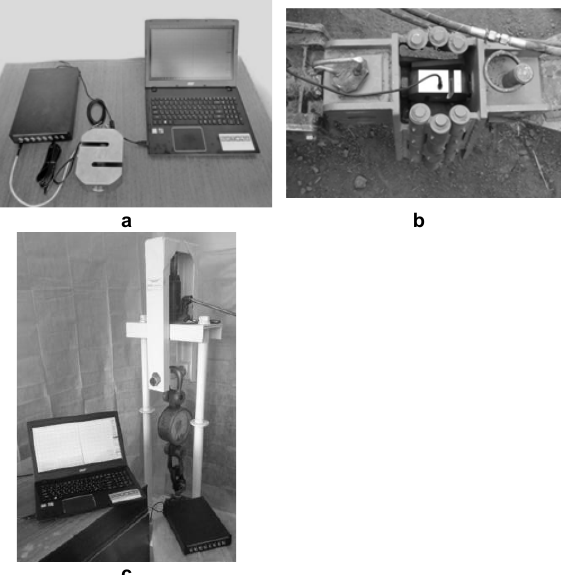
а – flat cutting tool; b – battery of disk working bodies with variable working depth; c –disk working bodies installed in pairs at an angle to the direction of movement. d – double drum press roller. Figure 3. Working bodies The flat-cutting working body of the presented